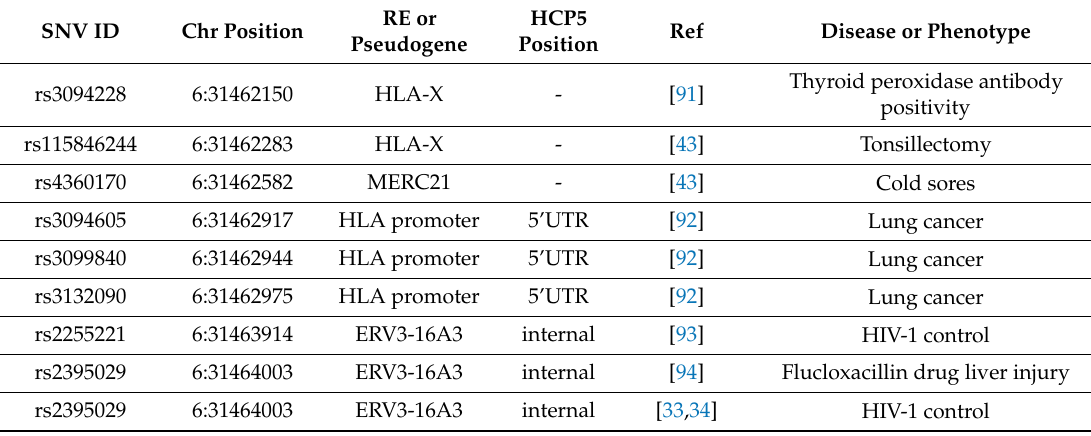
Table 3. Diseases and phenotypes associated with HCP5 SNV and retroelement